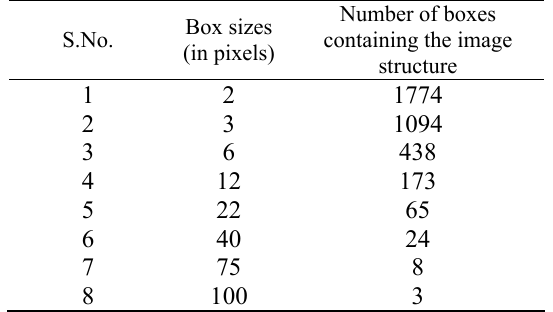
Table 1. The number of boxes counted for each of the box sizes for SSM of the face image of the first person in AT & T